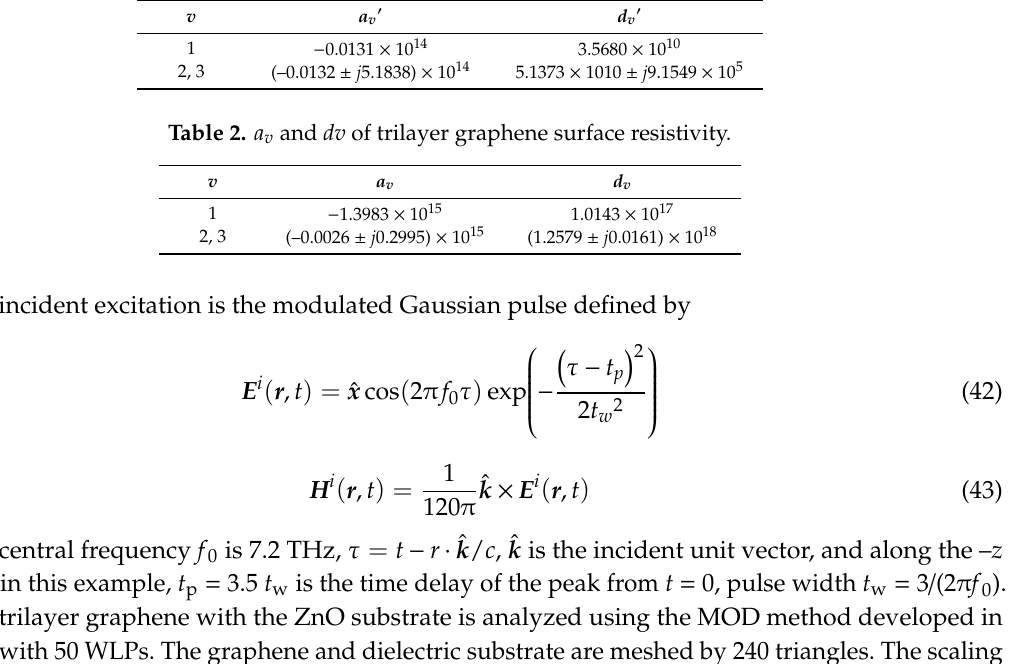
Table 1. a v (cid:48) and d v (cid:48) of trilayer graphene surface conductivity.